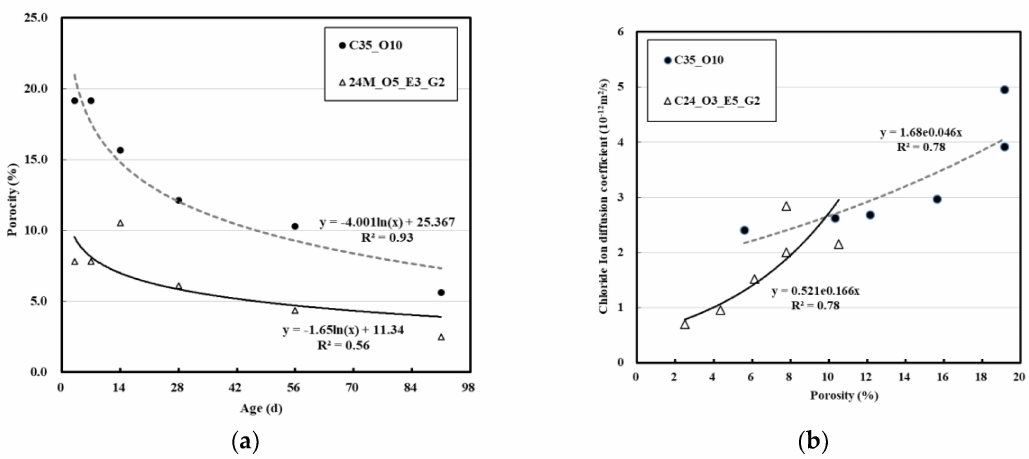
Figure 11. ( a ) Internal porosity of concrete with age; ( b ) relation between the porosity and chloride ion di ff usion coe ffi cient.